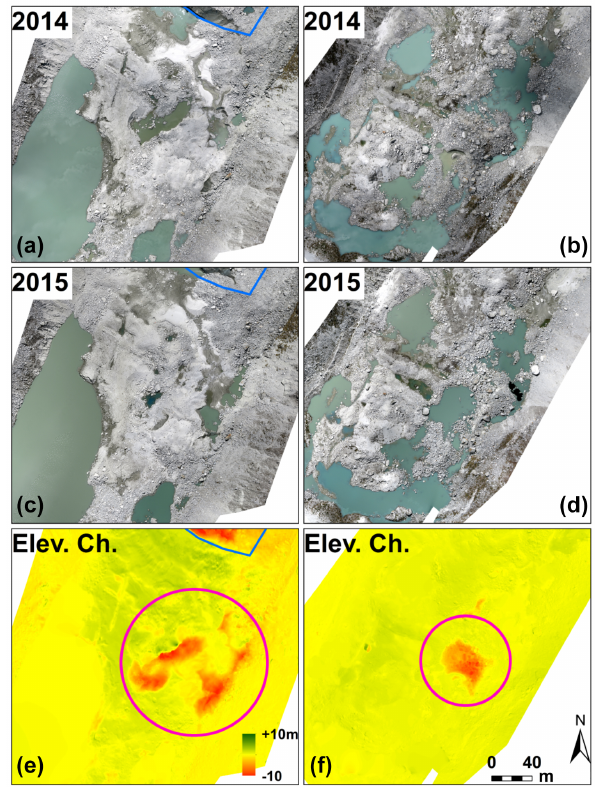
Figure 13. Locations of major elevation change (ice loss) within lake sediments (pink circles) indicate that buried glacier ice is still present. Low surface velocities were also measured here ( ∼ 2.5myr − 1 below calving face in left panels and ∼ 0.5myr − 1 at end of surveyed region in right panels), indicating these sediments are still connected to the main glacier tongue. Panels ( a and b ) show 2014 orthomosaic; panels ( c and d ) show 2015 orthomosaic; panels ( e and f ) show elevation change where 2014 elevation is subtracted from 2015 elevation (i.e. negative value is ice loss). Blue line is glacier tongue boundary. Note: elevation change values are trun- cated to ± 10m for display purposes. Location of panels is depicted in Fig. 7 inset boxes: 4 – left panels; 5 – right